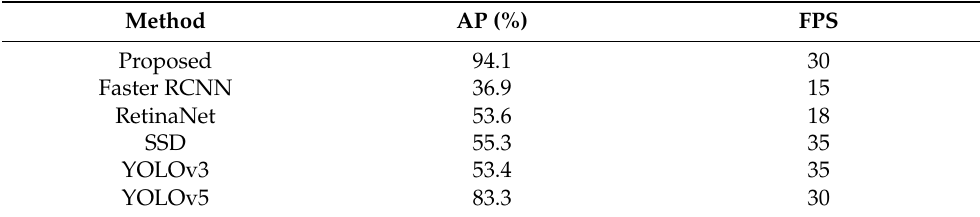
Table 2. Comparison between the proposed method and object detection methods.